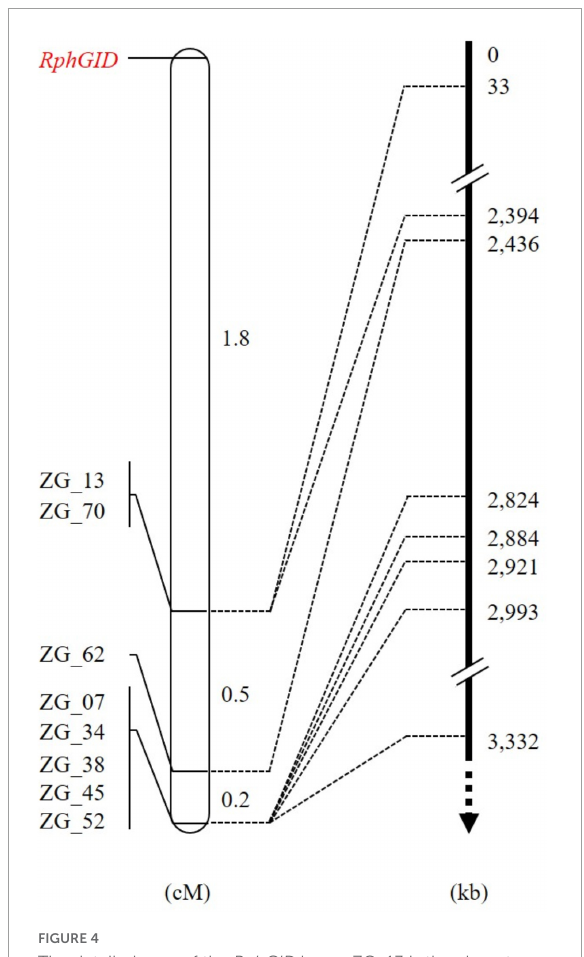
FIGURE4 The detailed map of the RphGID locus. ZG_13 is the closest marker to the RphGID locus. The arrow is toward the centromere of chromosome